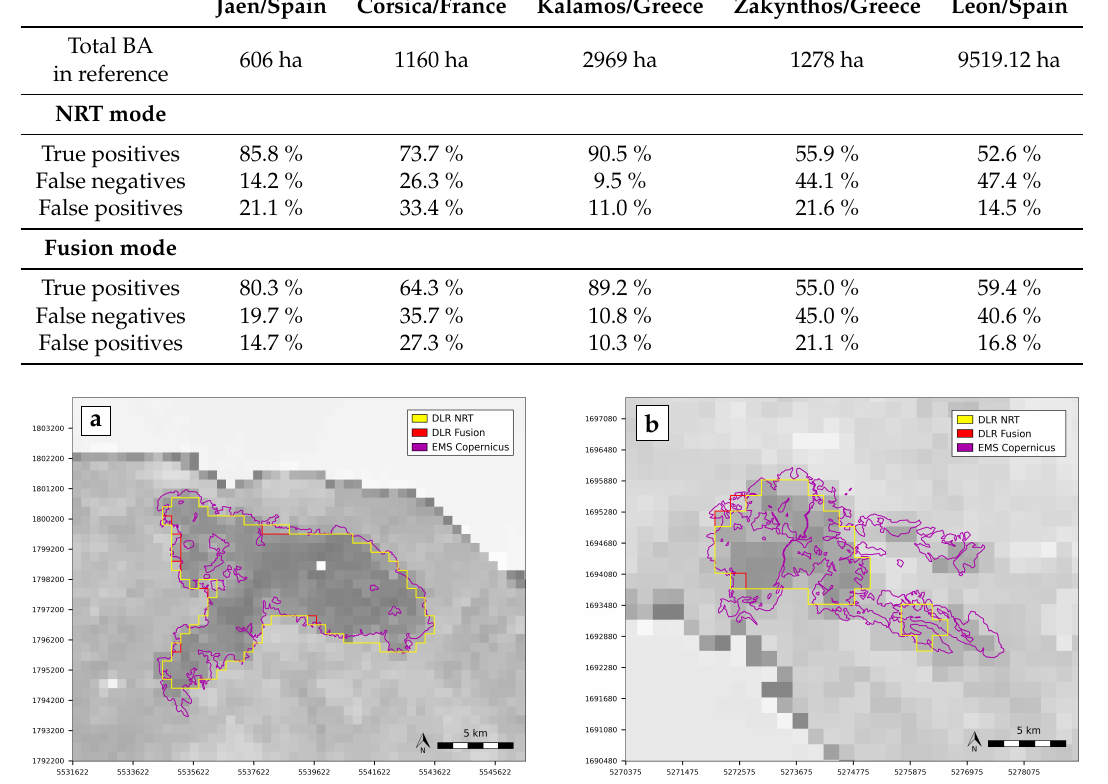
Figure 3. Burnt area perimeter results, shown together with Copernicus EMS reference